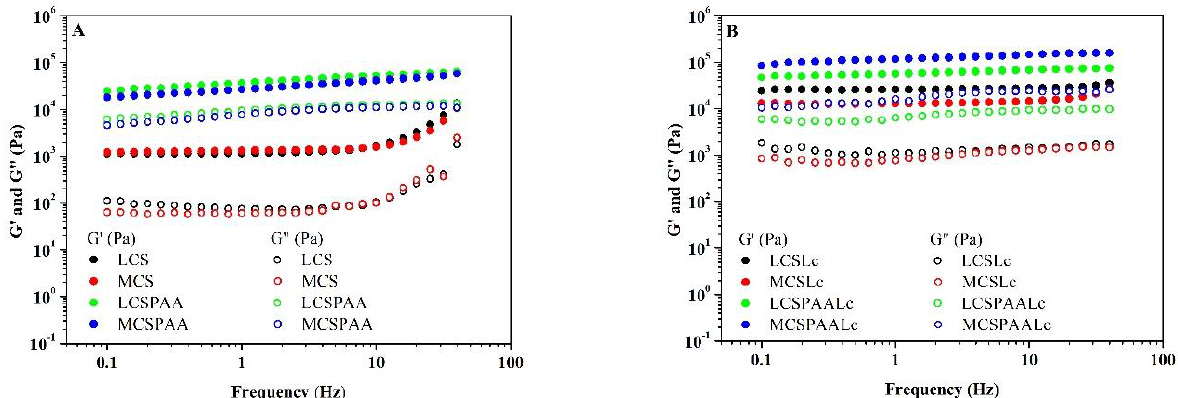
Figure 3. Effect of applied frequency on storage (G’) and loss (G”) moduli for the studied micro- spheres: ( A ) before immobilization procedure and ( B ) after immobilization procedure.